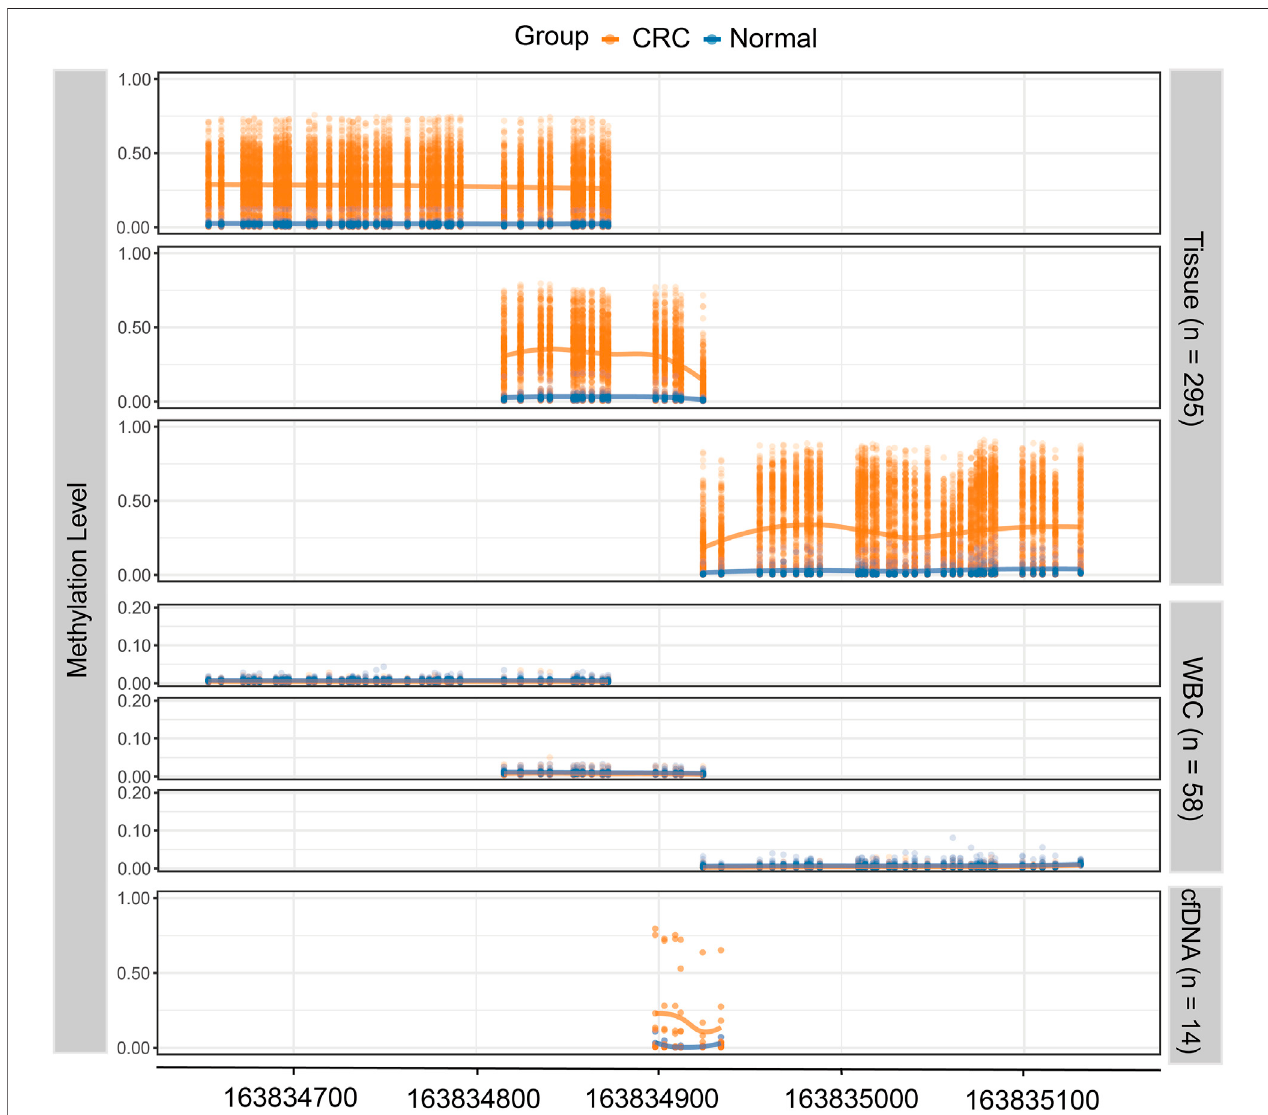
FIGURE 4 | The methylation level of the QKI target region in the validation dataset. The top three panels show the methylation level of 271 CRC tissues and 24 normal tissues, where each dot represents one CpG site for each sample. The middle three panels show the methylation level of white blood cells from CRC patients( n =29)andhealthy controls( n =29).Thelowestpanelshowsthemethylationlevelofcell-freeDNAsamplesfromCRCpatients( n =9)andhealthy controls ( n = 5).